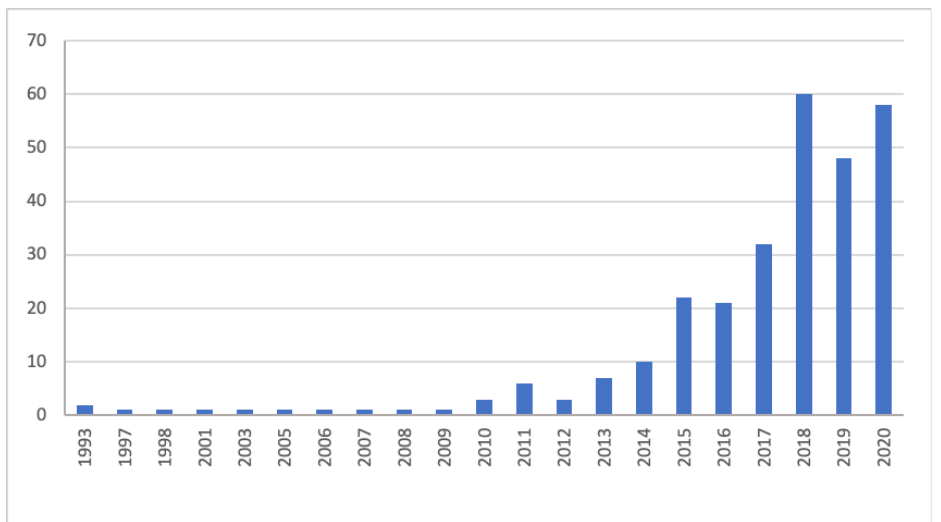
Figure 1. Bibliometric publications categorised with the keywords “Big Data”, “Artificial Intelli- gence”, “Machine Learning”, “Neural Networks”, “Natural Language Processing”. Source: WoS (543 publications).